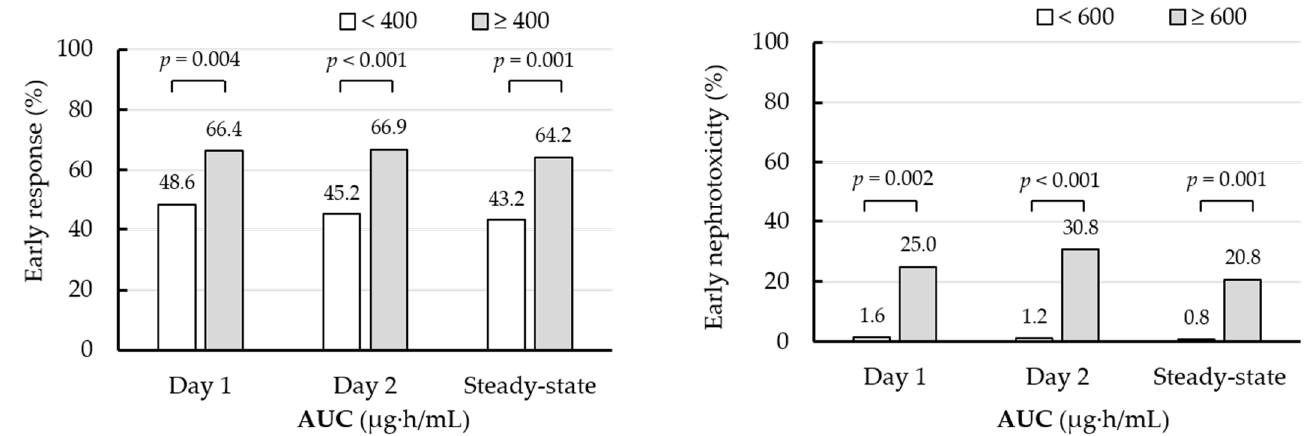
Figure 2. Early clinical response and early nephrotoxicity rates after 48–72 h of vancomycin adminis- tration according to the AUC on days 1–2 and at steady-state.